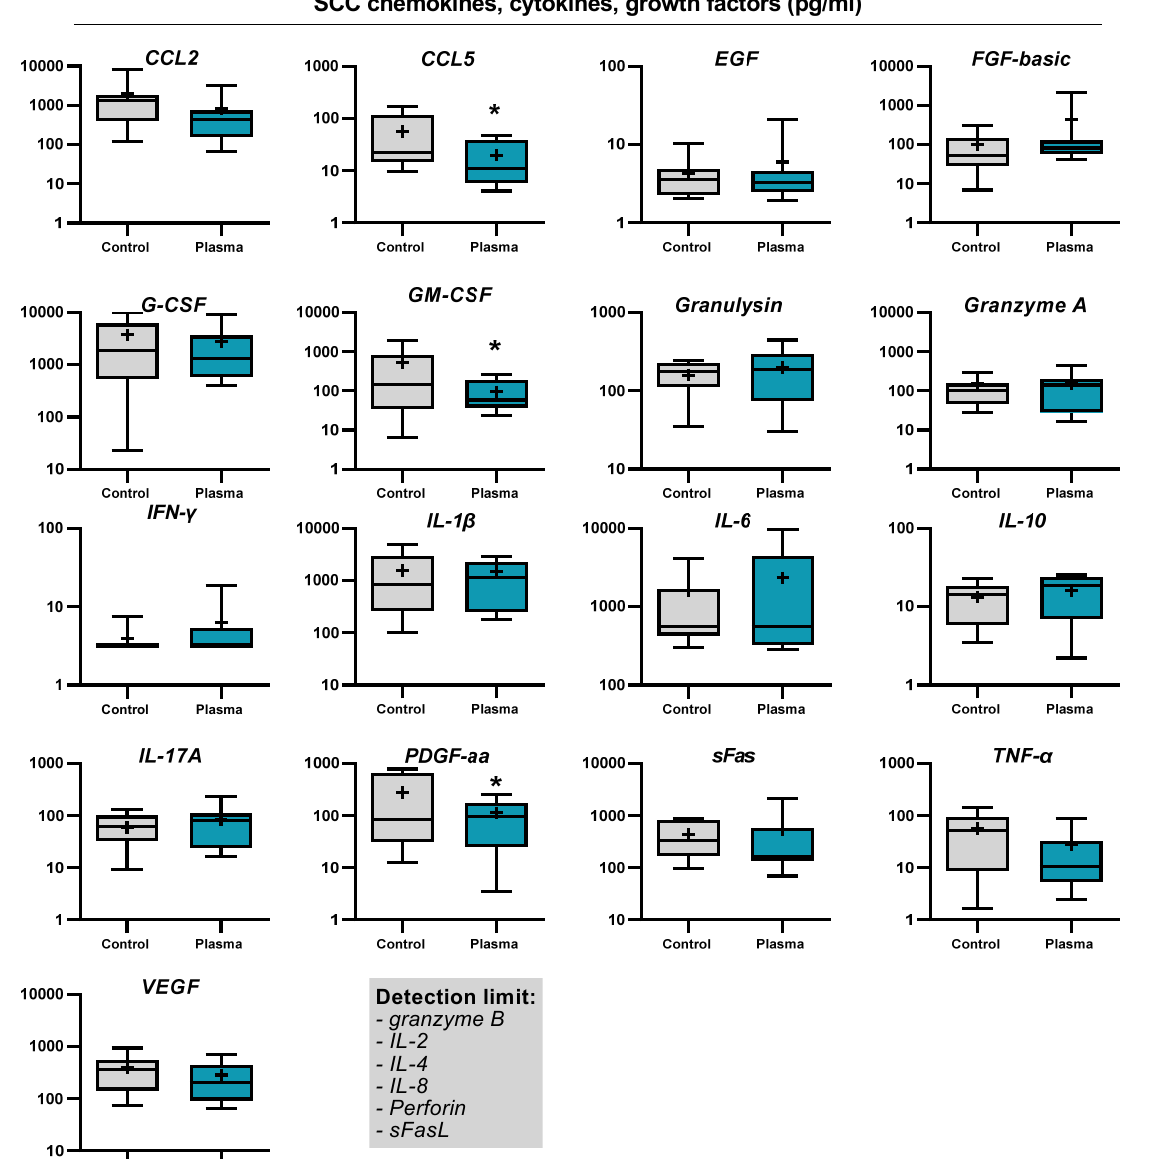
Figure 5. Secretion profile of SCCs: quantification of chemokines, cytokines, and growth factors in pg/mL in BCC tissue culture supernatants 24 h after exposure to gas plasma or argon gas. Data show boxplots from 6–8 patients, and statistical analysis was performed using t -test with p < 0.05 (*).